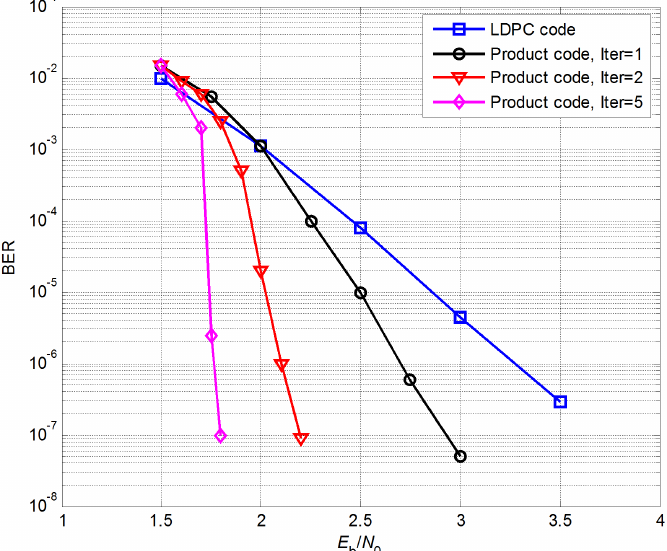
Figure 7. Iterative decoding performance of the product code with LDPC (576, 288) and Hamming (511,